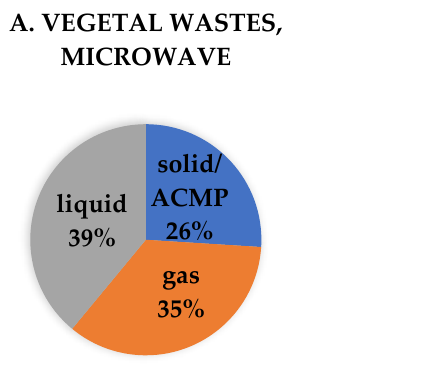
Figure 8. Comparison between the average yields obtained in case of vegetable waste pyrogenation by microwave heating ( A ), waste by conventional heating ( B ), and wood by conventional heating ( C ).